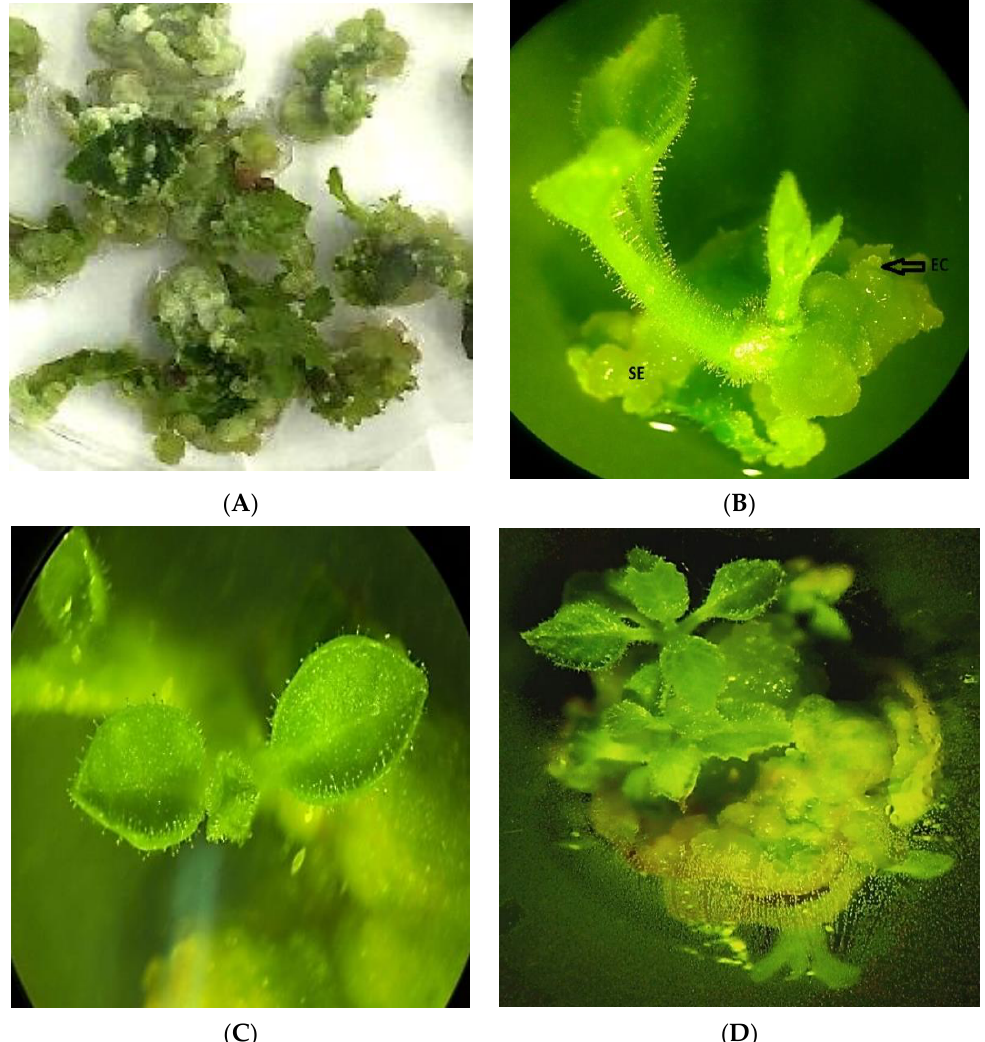
Figure 2. Induction of callus tissues ( A ) and plant regeneration from embryogenic callus from fragments of leaf on MS media with 4.5 µM TDZ + 2.8 µM IAA ( B – D ). Symbols in ( B ): SE — somatic embryos, EC — embryogenic calli with small needle-like embryogenic structures at early stages of SE (micro photo).